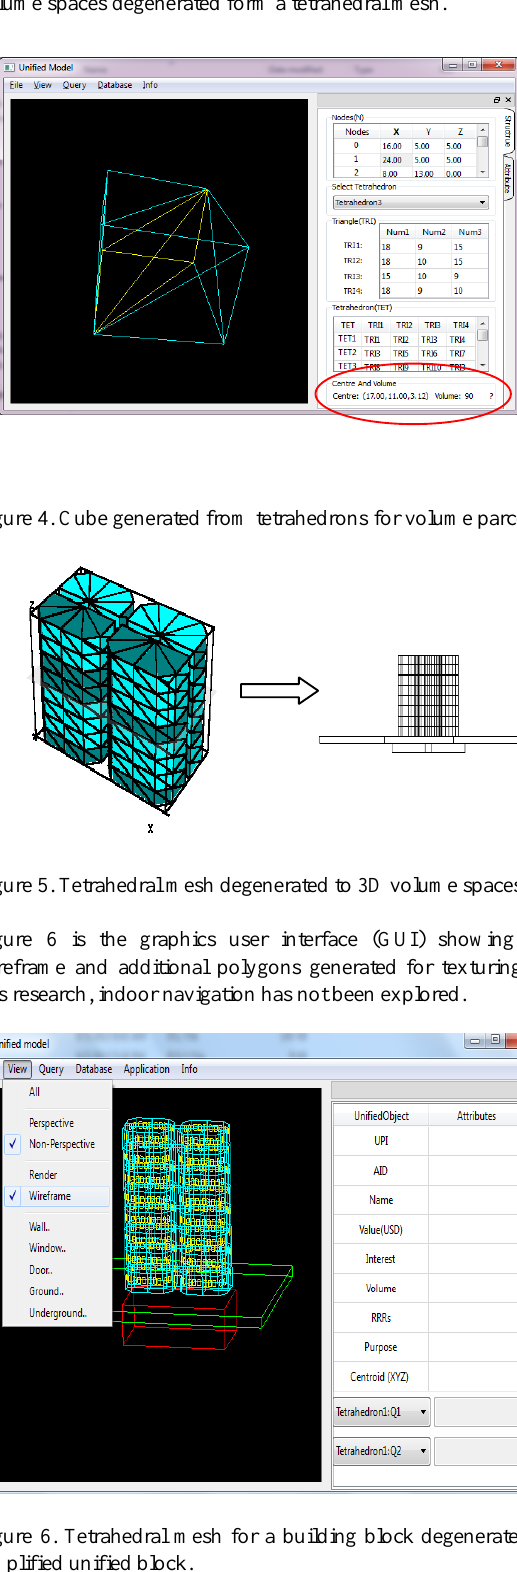
Figure 4 is the tetrahedral mesh generated for the basic cube.